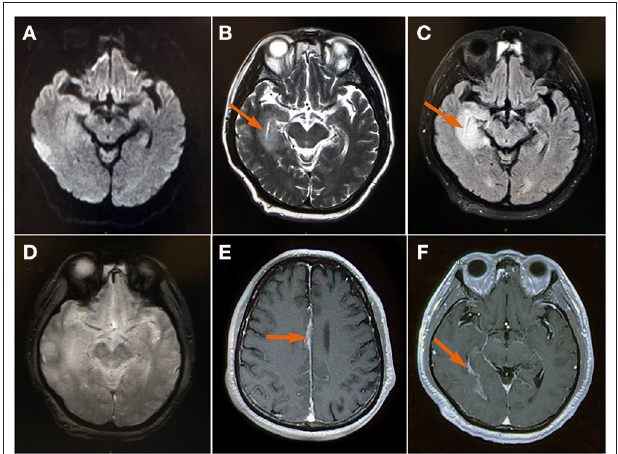
FIGURE 1 | MRI brain (A) Axial DWI and (D) GRE sequence showed insignificant findings; (B) axial T2WI showed bright signal axial (arrow); (C) FLAIR image showed an edematous swollen temporal lobe (arrow); (E,F) Contrast-enhanced images demonstrated a fine linear enhancement of cerebral falx and bilateral choroid (arrow). DWI, diffusion-weighted imaging; FLAIR, fluid-attenuated inversion-recovery; GRE (gradient echo); T2WI, T2 weighted